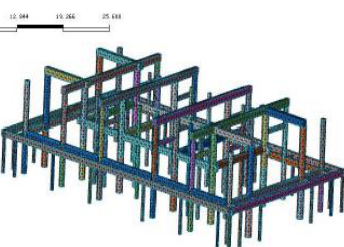
Figure 12. Load-bearing wood Construction framework grid